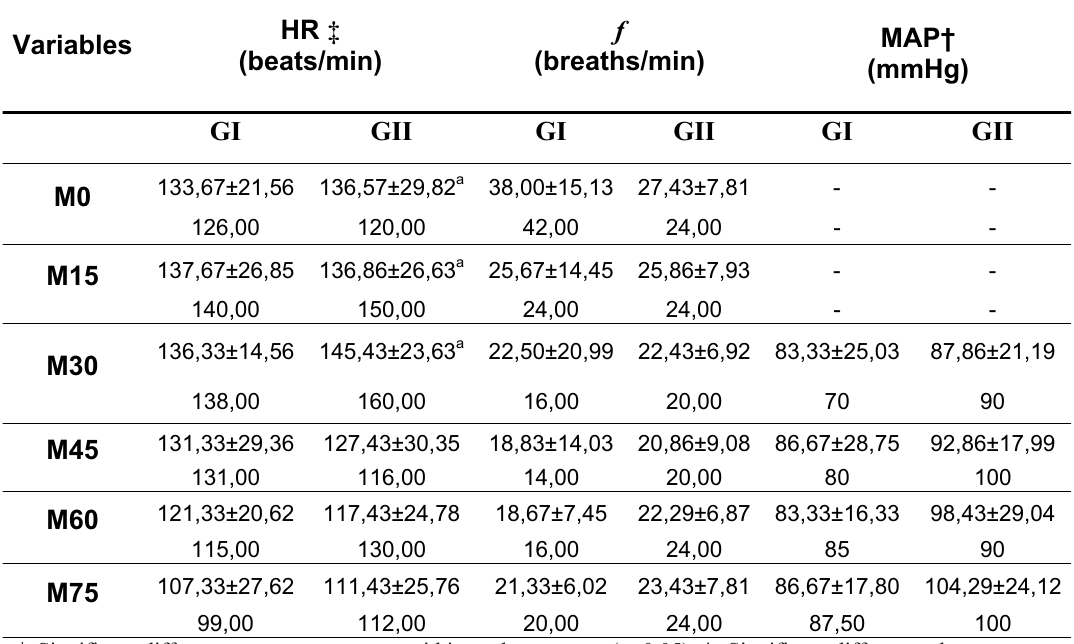
TABLE 2 - Distribution of means ± standard deviations and medians, according to the group (GI – control and GII – SAF) for the clinical parameters heart rate (HR), respiratory rate (ƒ) and Mean arterial pressure (MAP) in bitches submitted to